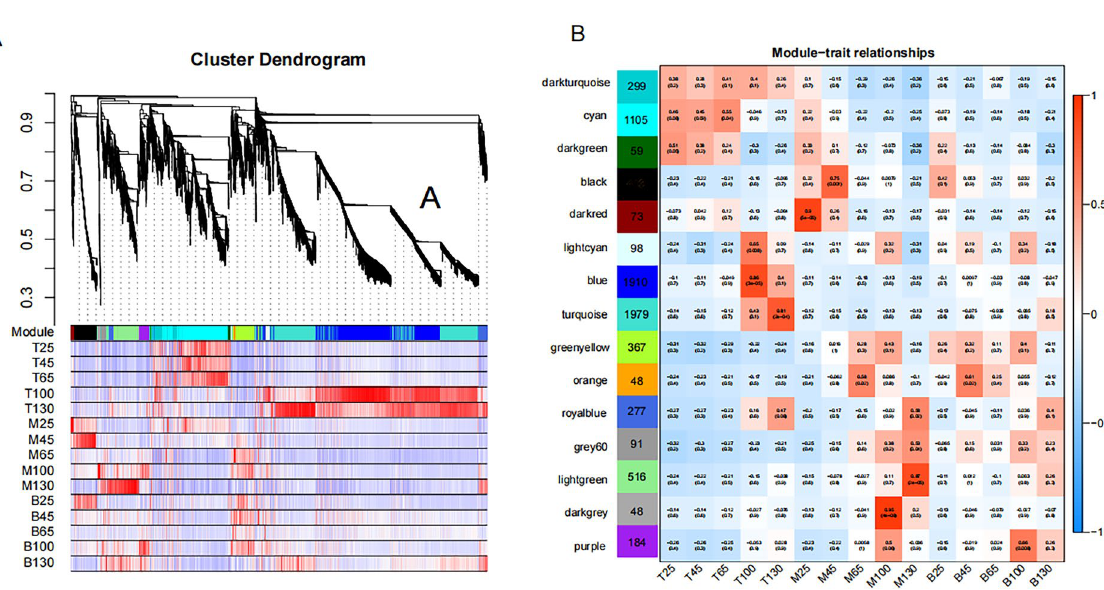
Figure 3. Through WGCNA analysis, 7417 DEGs were divided into 15 distinct modules. ( A ) Gene dendrogram and correlation heat map between gene and module. Red represents positively correlated, blue depicts negatively correlated; ( B ) Correlation heat map between modules and sample. The figures were generated by R WGCNA package (version 1.71, https:// cran.r- proje ct. org/ packa ge=